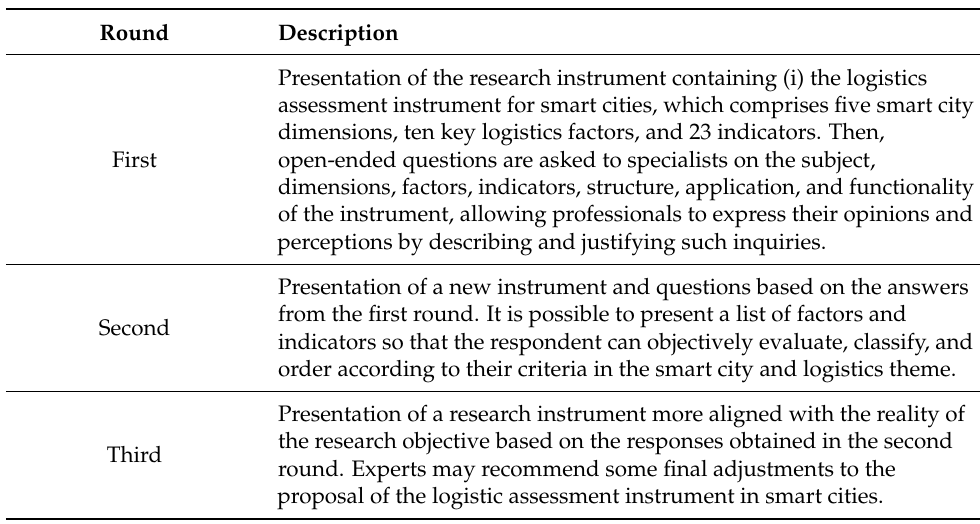
Table 1. Description of the Delphi method application and analysis